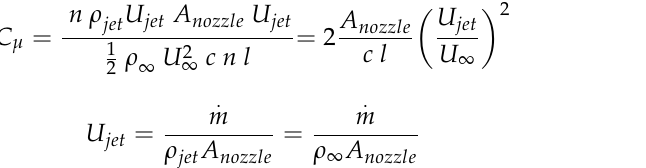
Figure 5. Grid system in the fluidic oscillator.